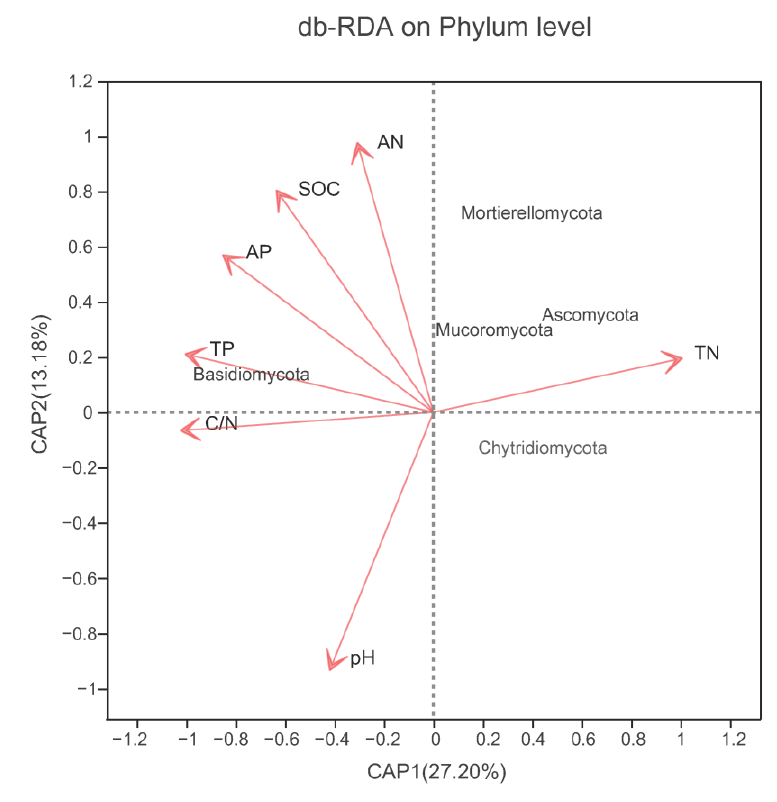
Figure 9. RDA of the dominant fungal phyla in soil constrained by soil variables.